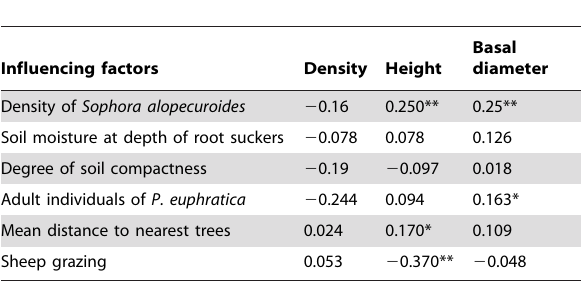
Table 2. Correlation between influencing factors and growth characteristics of P. euphratica root suckers.